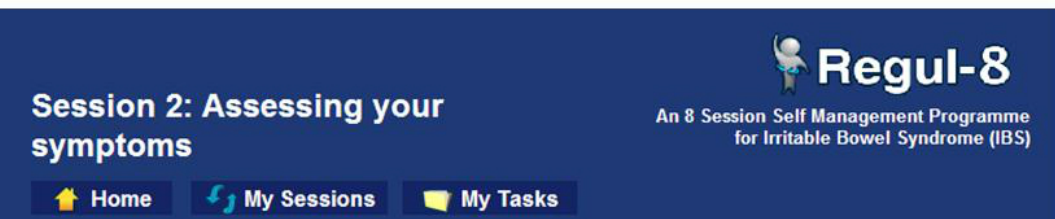
Figure 1. A MIBS webpage that gives participants an example of how thoughts, behaviors, emotions, and symptoms can